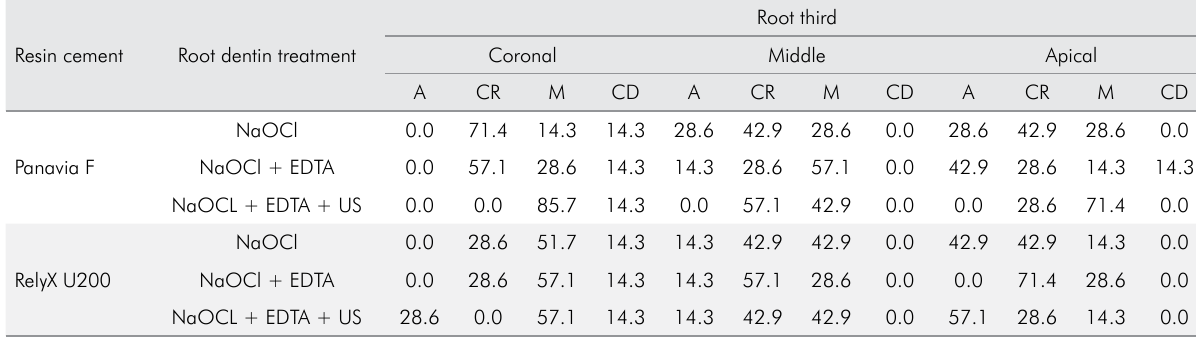
Table 2. Failure pattern distribution. Resin